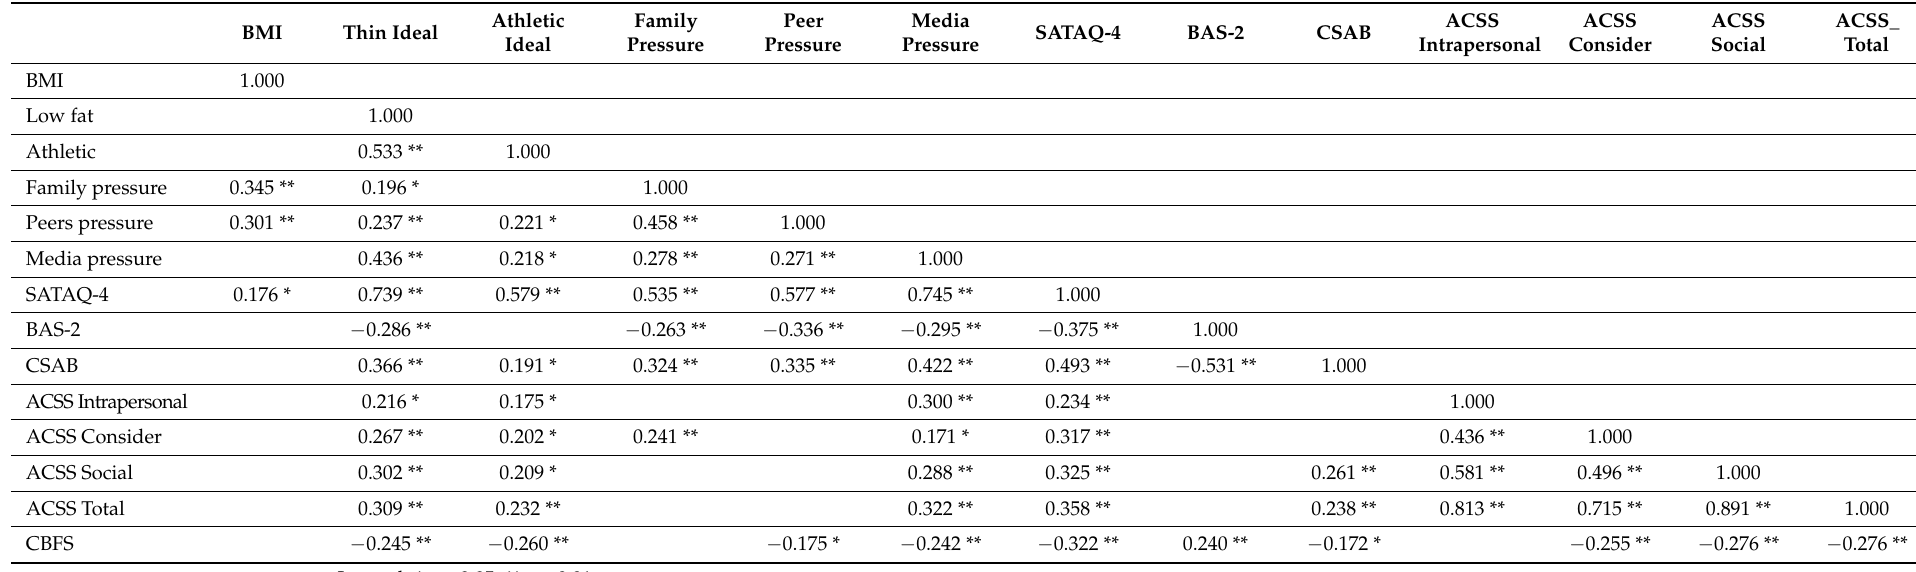
Table 5. Spearman correlation coefficients between the model